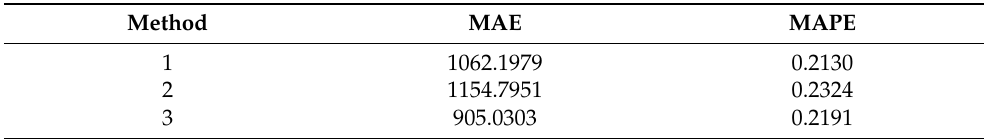
Table 9. MAE and MAPE error values for individual methods.